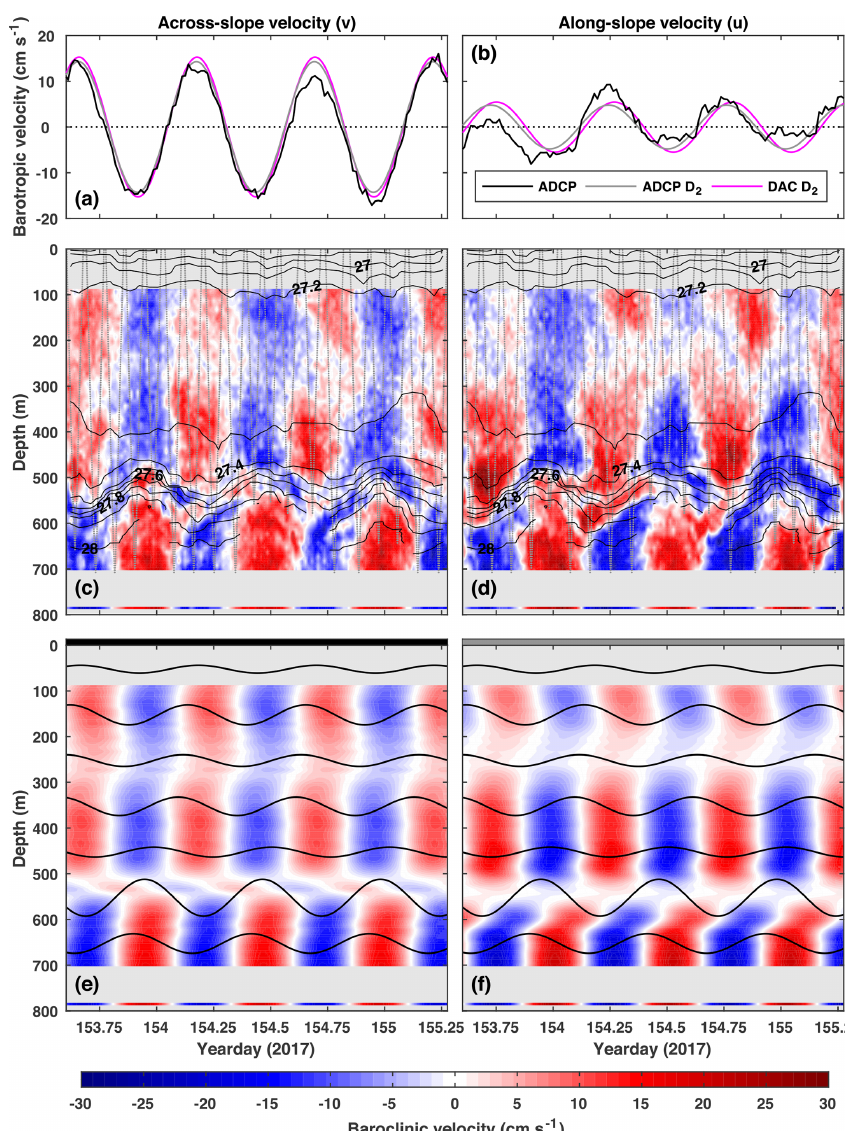
Figure 3. (a) Across-slope barotropic velocity (black), the D 2 component (grey), and a D 2 harmonic fit to DAC velocity (magenta). (c) Across-slope baroclinic velocity (colour) overlaid with potential density (black contours, interval: 0.1kgm − 3 ). (e) The D 2 component of across-slope baroclinic velocity (colour) overlaid with the D 2 component of vertical isopycnal displacement every 100m (black lines). Panels (b) , (d) , and (f) are the same as (a) , (c) , and (e) but for along-slope